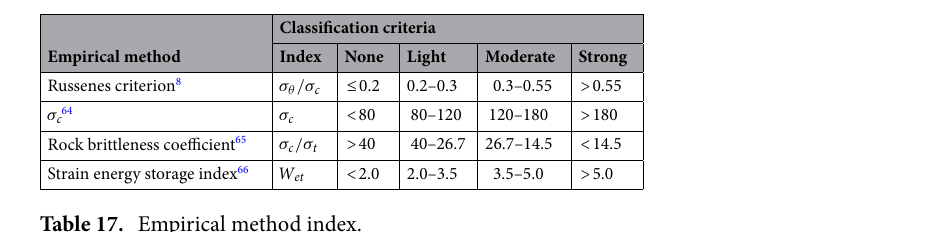
Table 17. Empirical method index.